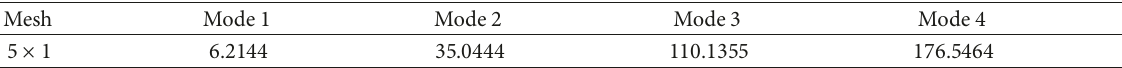
Table 3: First five eigenfrequencies of the cantilevered smart beam (Hz).